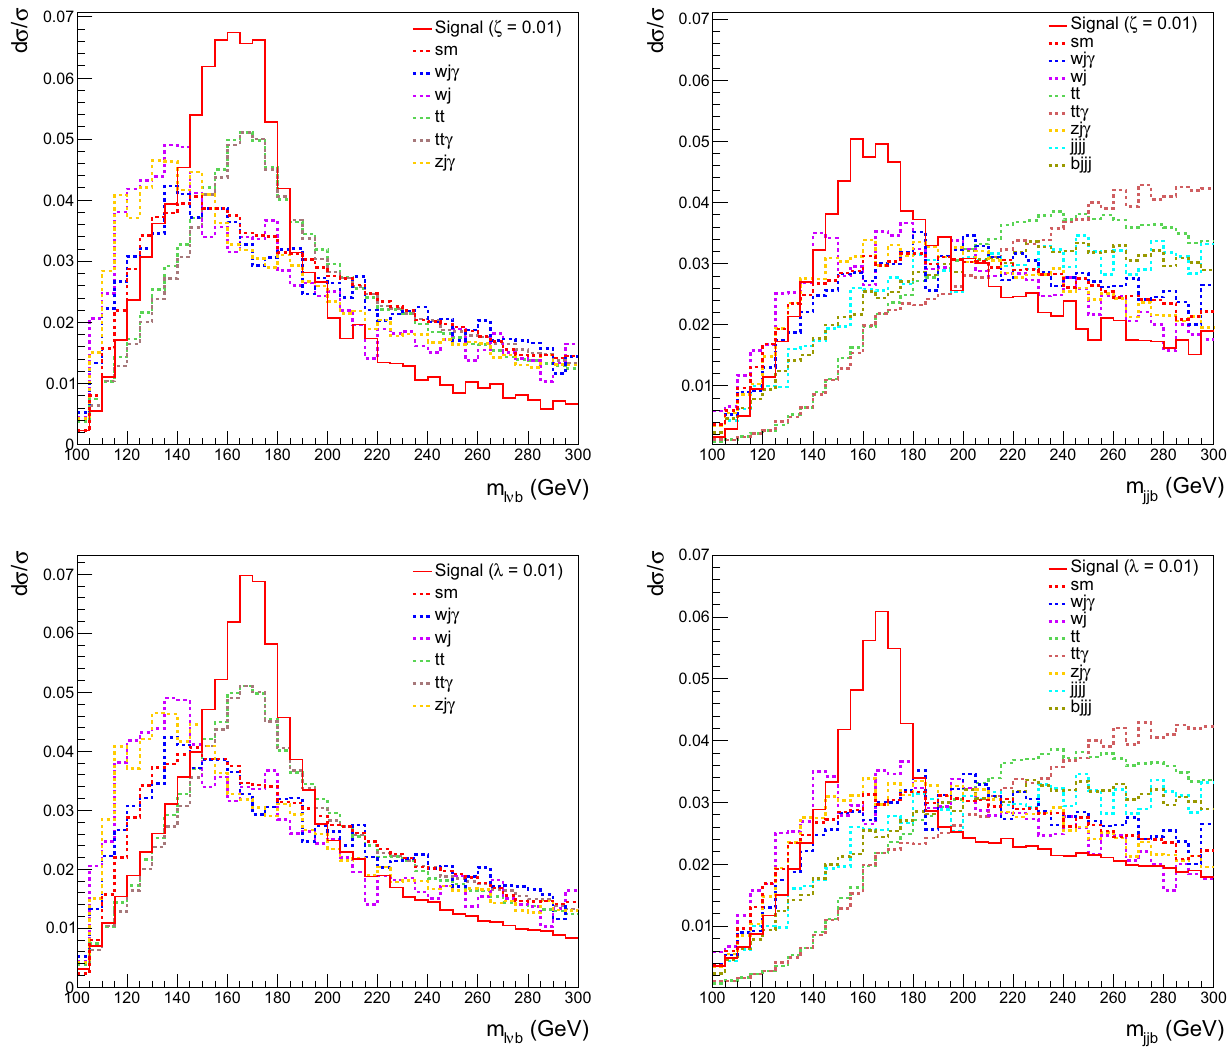
Fig. 5 The reconstructed invariant mass distributions of signal ( ζ q = 0 . 01 and λ q = 0 . 01 on the top and bottom, respectively) and relevant SM background processes for leptonic (on the left) and hadronic channel (on the